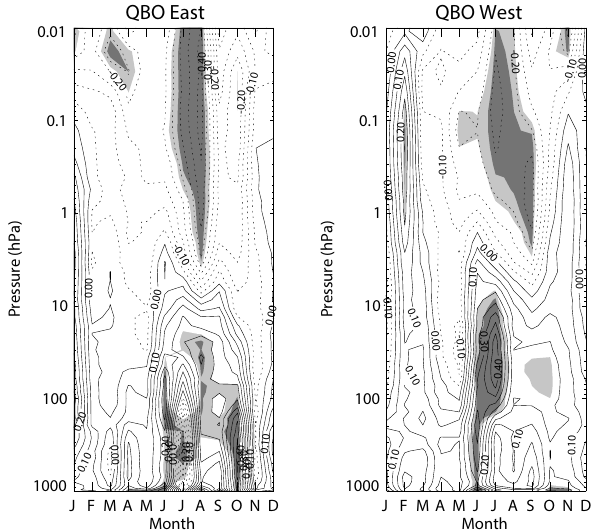
Fig. 7. Contour plot of the Spearman rank correlation between the monthly averaged geopotential heights at 90 ◦ N, as a function of pressure level and month, and the 255nm spectral irradiance for both the QBO east (left) and west (right) phases in WACCM4a. Light and dark shading indicates the significance of the correlations (90% and 95%) using a two-sided significance test. Contour inter- val 0.05. Negative values are